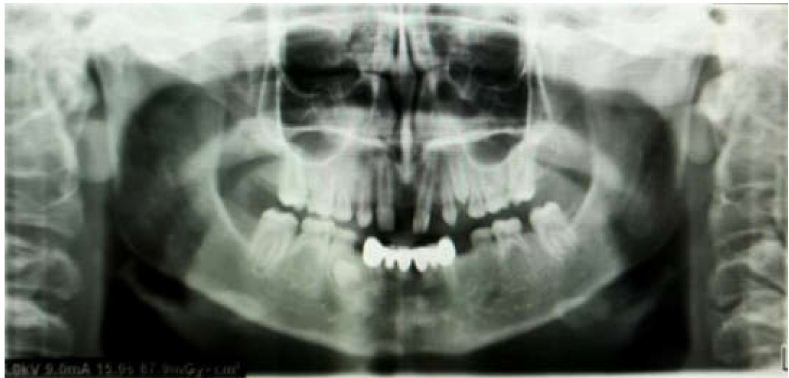
Figure 4. Panoramic X-ray. Post-operative, 36 months’ follow-up.